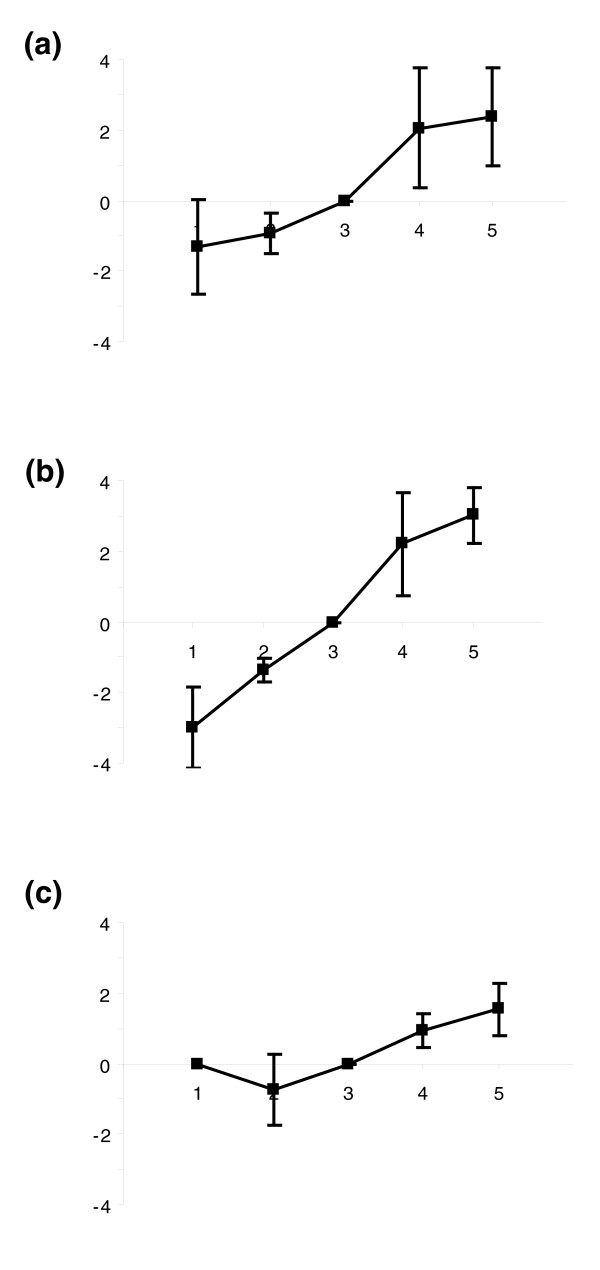
Expression profiles of four selected proteins during larval development. Expression levels (y-axis, expressed in natural log scale) over 5 days of larval growth (x-axis) are shown for 3 proteins discussed in the text: (a) imaginal disc growth factor [GenBank:66514614], (b) odorant binding protein 14 [GenBank:94158822], (c) apismin [GenBank:58585112]. Error bars represent one standard deviation.